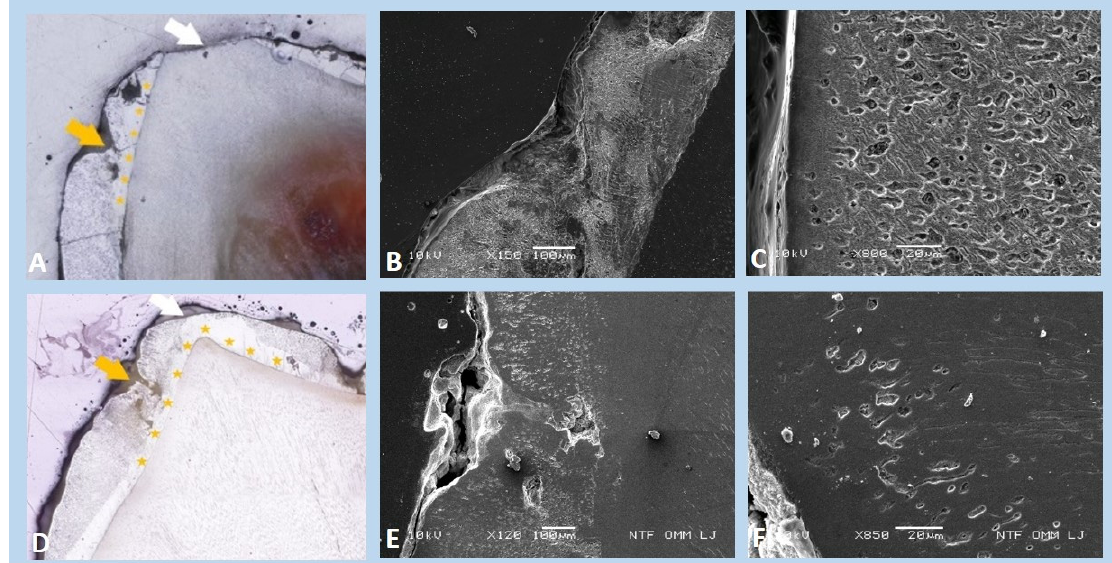
Figure 3. Images of ( A – C ) an exfoliated and etched lower deciduous first molar (tooth 74) of the girl (III.6) from family I and ( D – F ) a non-etched upper deciduous second molar (tooth 65) of the older girl (IV.4) from family II. ( A , D ) Light microscopy reveals a pitted enamel surface (yellow arrows) that is also missing in some areas due to attrition (white arrows). Two layers of enamel are visible, with the inner layer (asterisks) being better mineralised (etched, × 60 and non-etched, × 100, respectively). ( B , E ) Scanning electron microscopic (SEM) images of these same surfaces of both affected teeth show rather normal structures in the inner enamel layer and irregular histology with numerous voids and amorphous artefacts in the outer layer (etched, × 150, SEI and non-etched, × 120, SEI, respectively). ( C , F ) Under higher magnification, we see profoundly porous enamel and a reduced number of enamel prisms with increased inter-prism space in the outer layer (etched, × 800, SEI and non-etched, × 850,